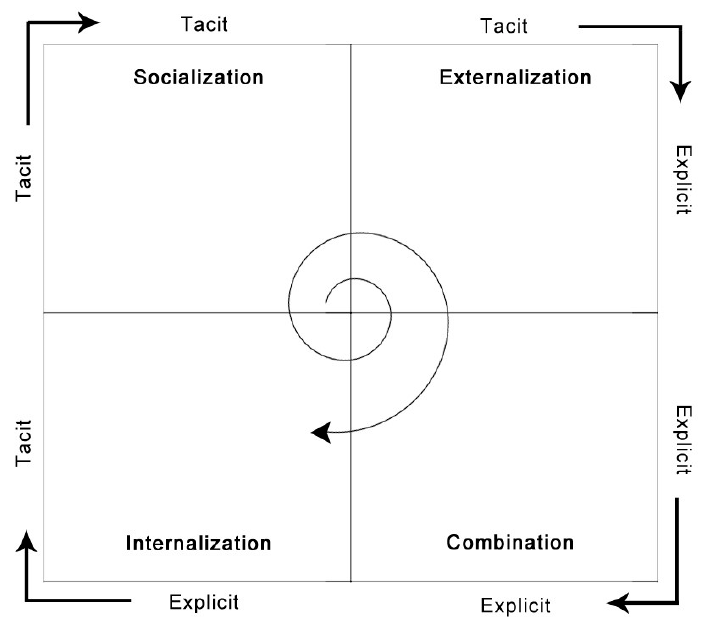
Figure 1. The knowledge spiral